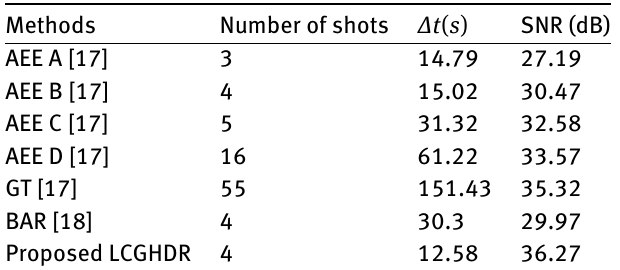
Table 5: SNR value for the different method